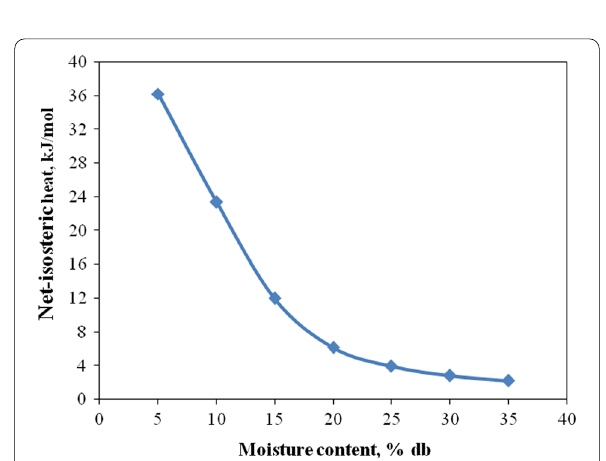
Fig. 7 Variation of net isosteric heat of sorption with moisture content in karaya